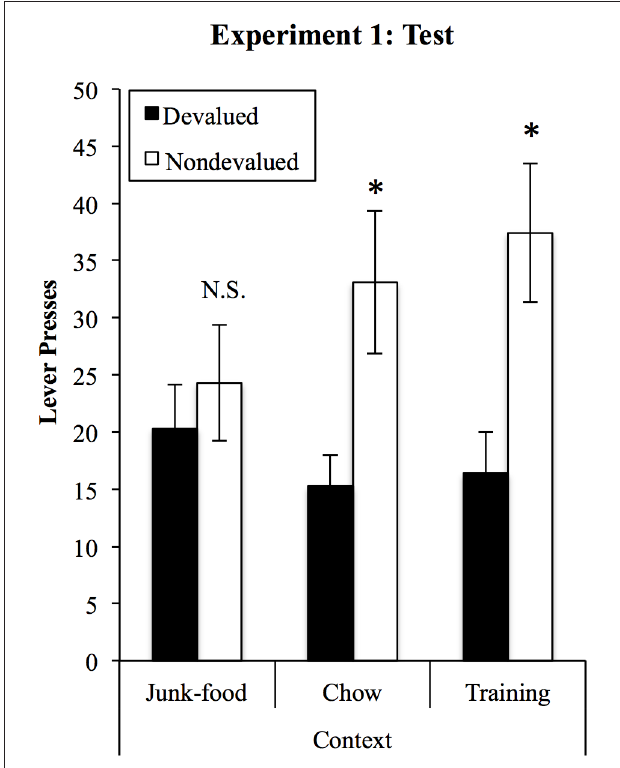
FIGURE 3 | A JF context impairs sensitivity to outcome devaluation. Sensitivity to devaluation was tested in the three contexts, within-subjects and in a counterbalanced order. After devaluation of one outcome by specific satiety, rats selectively reduced responding on the lever that had earned that outcome in training, but only in the chow and training contexts. When tested in the JF context, performance was insensitive to devaluation, with no overall difference in responding between contexts. ∗ Indicates p < 0.05, N.S.,